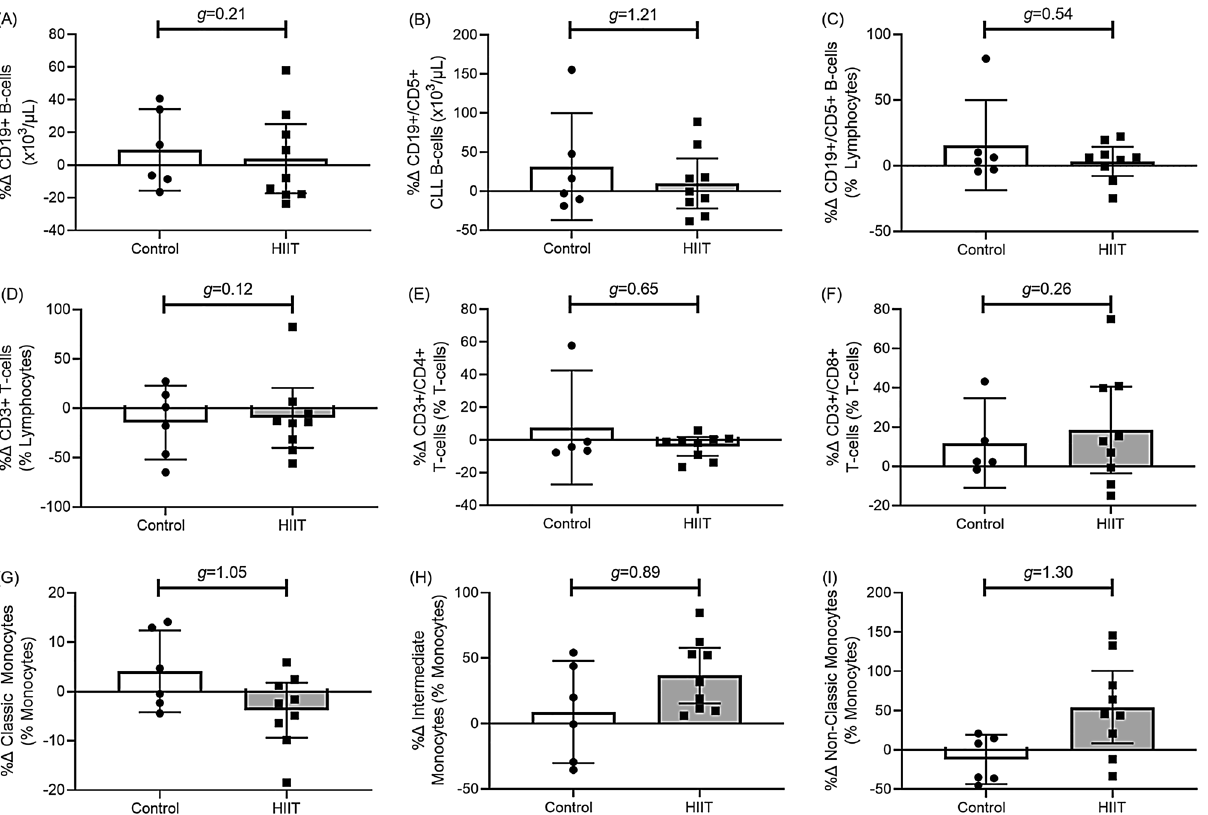
Figure 4. Mean (95% C.I.) percentage change (%∆) with Hedges G ( g ) group differences between HIIT and controls for B-cells ( A – C ), T-cells ( D – F ), and monocytes ( G – H